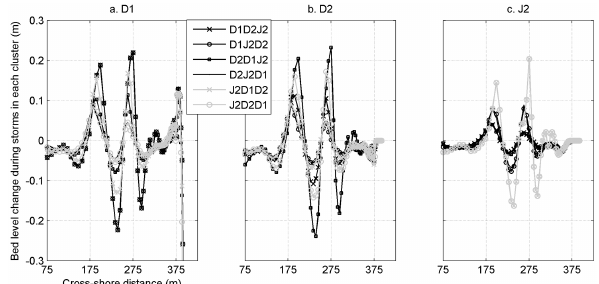
Figure 6. Bed level change from 75 to 400m cross-shore dis- tance during each storm event within each storm cluster. A posi- tive change indicates accretion and negative is erosion. The erosion in (a) at the dune frontage reaches − 0.71, − 0.71, − 0.70, − 0.73, − 0.77 and − 0.72m in the order of the legend; not shown to enable a consistent and clear y axis